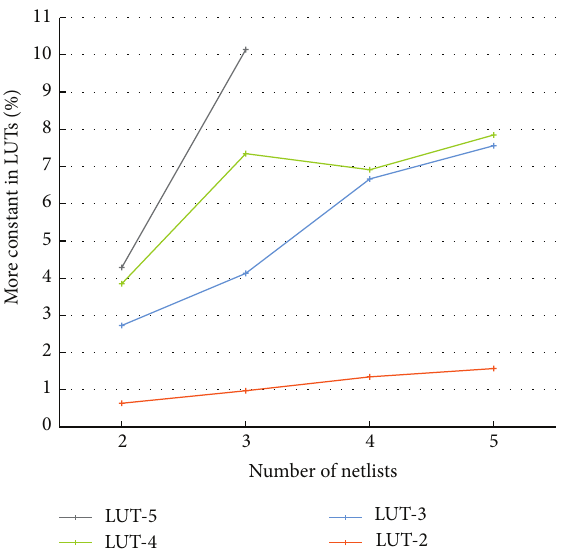
Figure 20: Constant increase in CLBs after reordering.